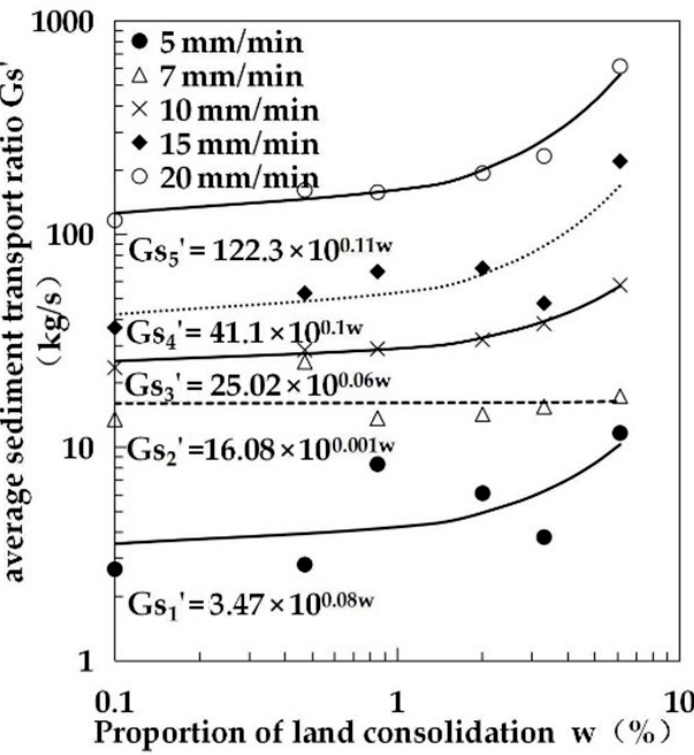
Figure 27. Changes in the average sediment transport ratio with land consolidation proportion under different rain intensities.